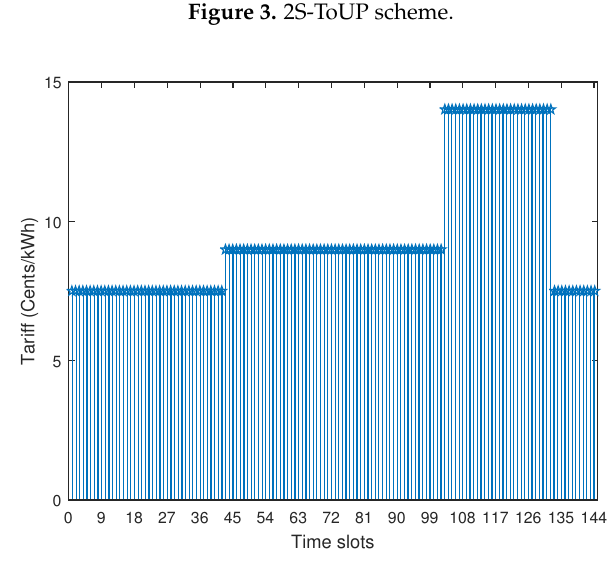
Figure 3. 2S-ToUP scheme.